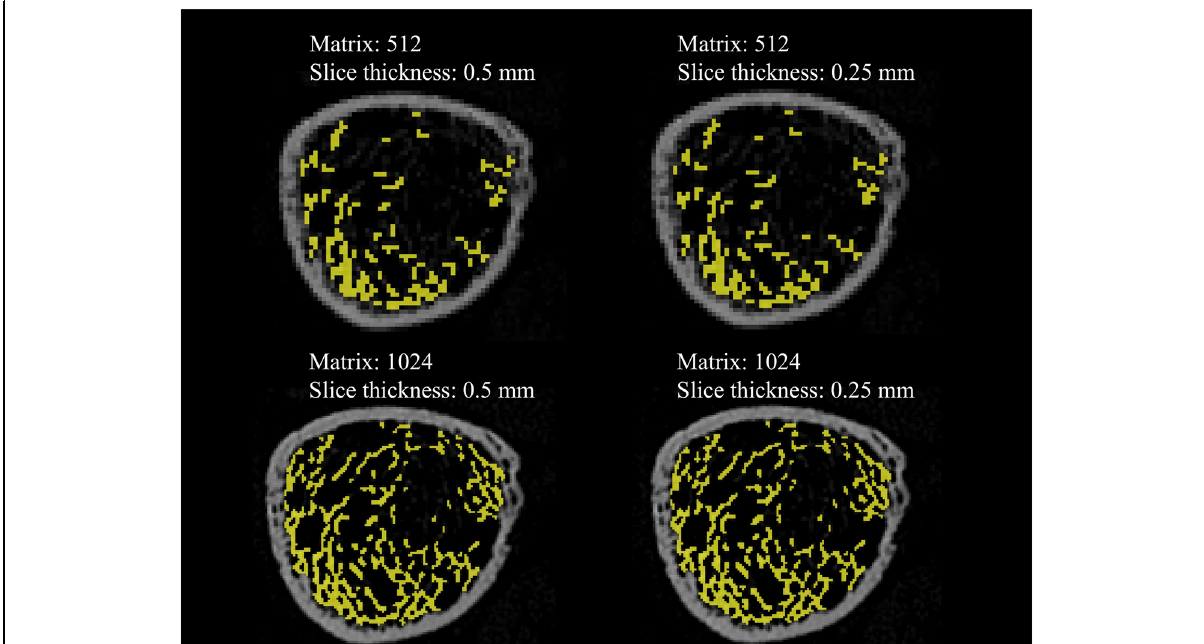
Fig. 6 Extracted images representative of the trabecular bone in the human distal tibia on ultra-high-resolution computed tomography (UHRCT). The matrix numbers were 512 × 512 and 1024 × 1024 and the slice thicknesses were 0.5 mm and 0.25